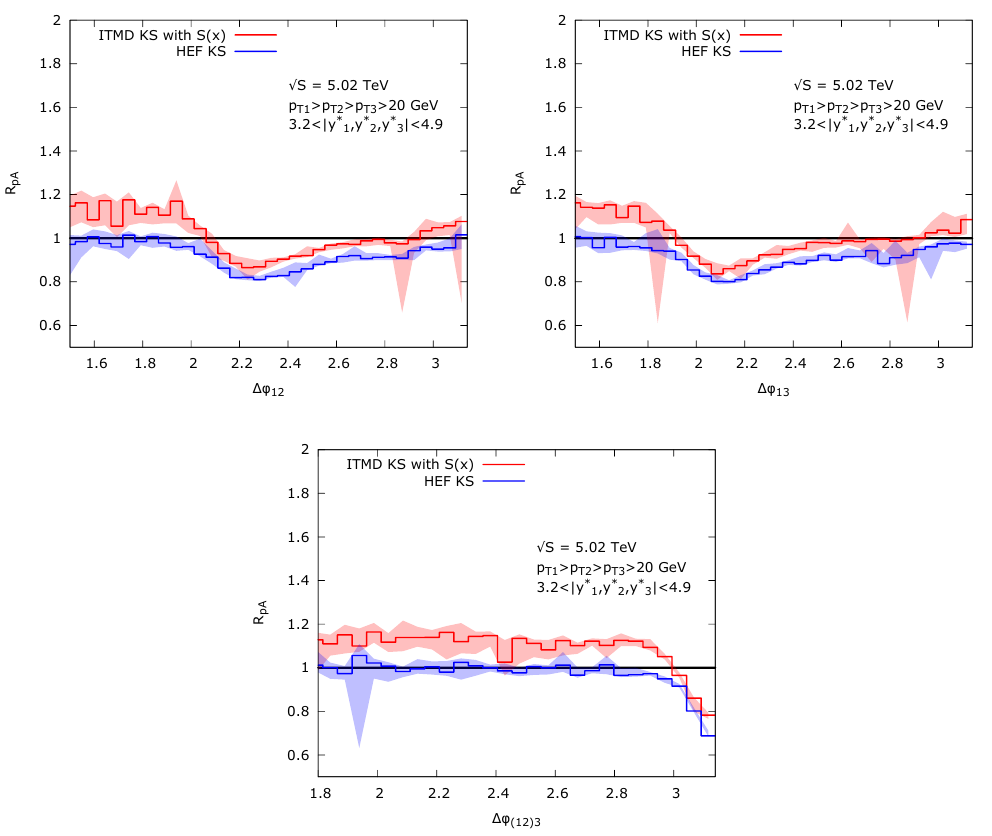
Figure 3 . Nuclear modi(cid:12)cation ratio in azimuthal di(cid:11)erences (cid:1) (cid:30) 12 , (cid:1) (cid:30) 13 and (cid:1) (cid:30) calculation predicts less suppression in the corresponding back-to-back regions comparing to HEF and displays up to 10% of an enhancement of the p-Pb cross section away from the correlation limit (for the possible origin of this e(cid:11)ect see the discussion in the main text).